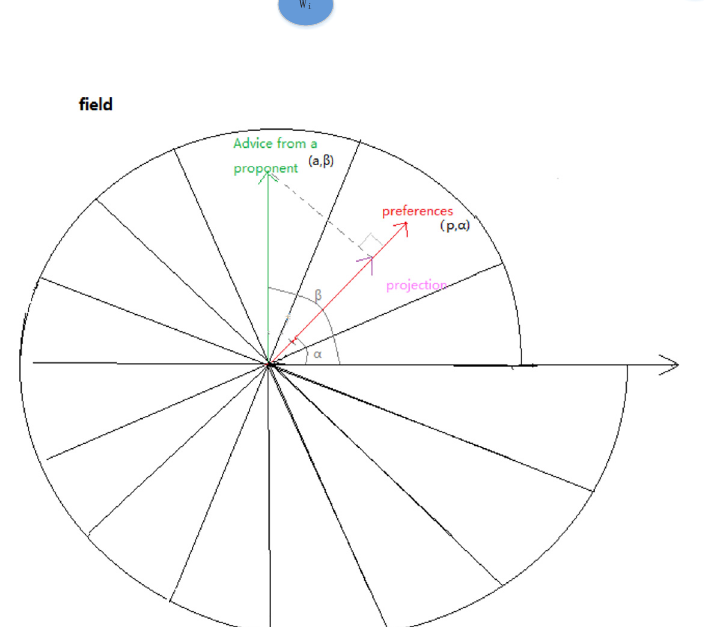
Figure 5. Proposed